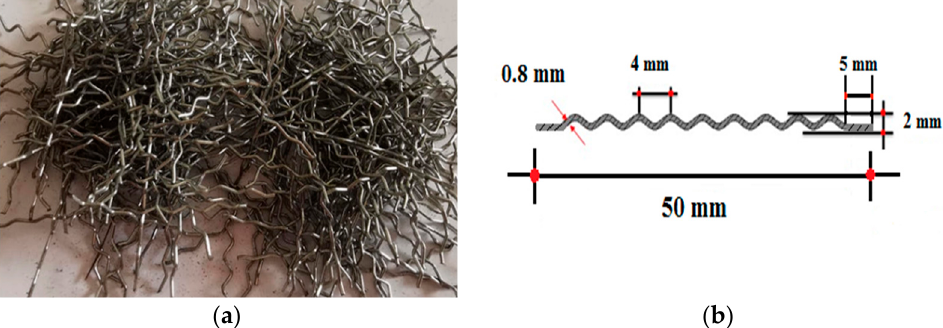
Figure 2. The appearance of corrugated and hooked-end steel fibers: ( a ) Clump of the steel fibersand ( b ) Steel fiber size. Table 2. Mechanical properties of steel